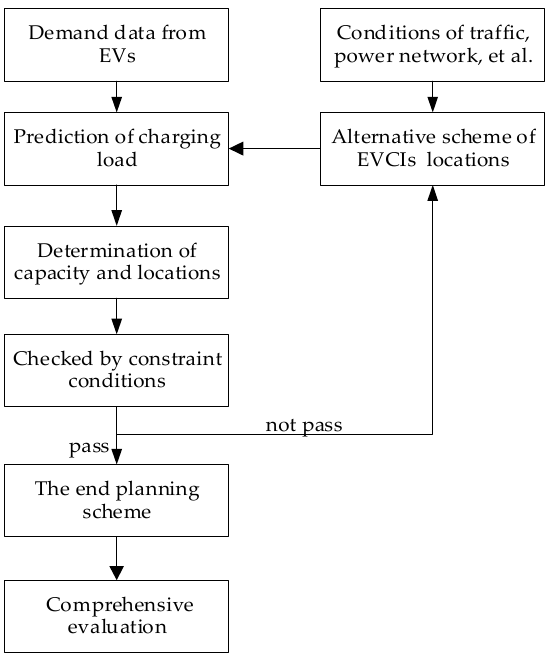
Figure 1. The charging infrastructure planning flowchart.